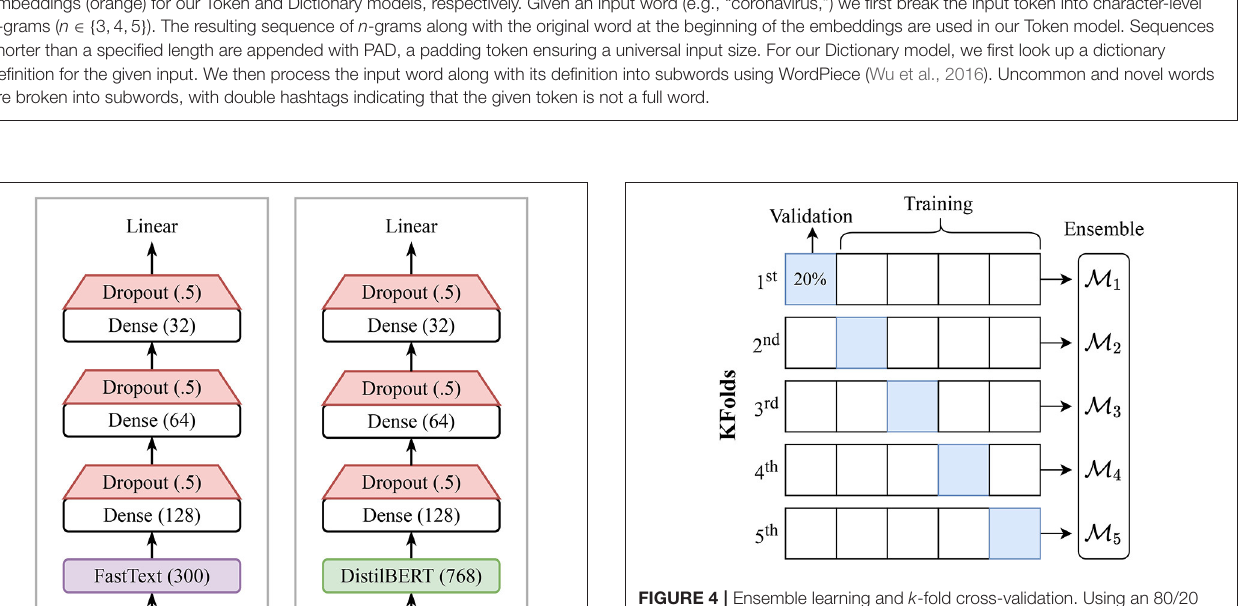
FIGURE 4 | Ensemble learning and k -fold cross-validation. Using an 80/20 split for training/validation, we train our models for a maximum of 500 epochs per fold for a total of 5 folds. We use the model trained from each fold to build an ensemble because the average performance of an ensemble is less biased and better than the individual